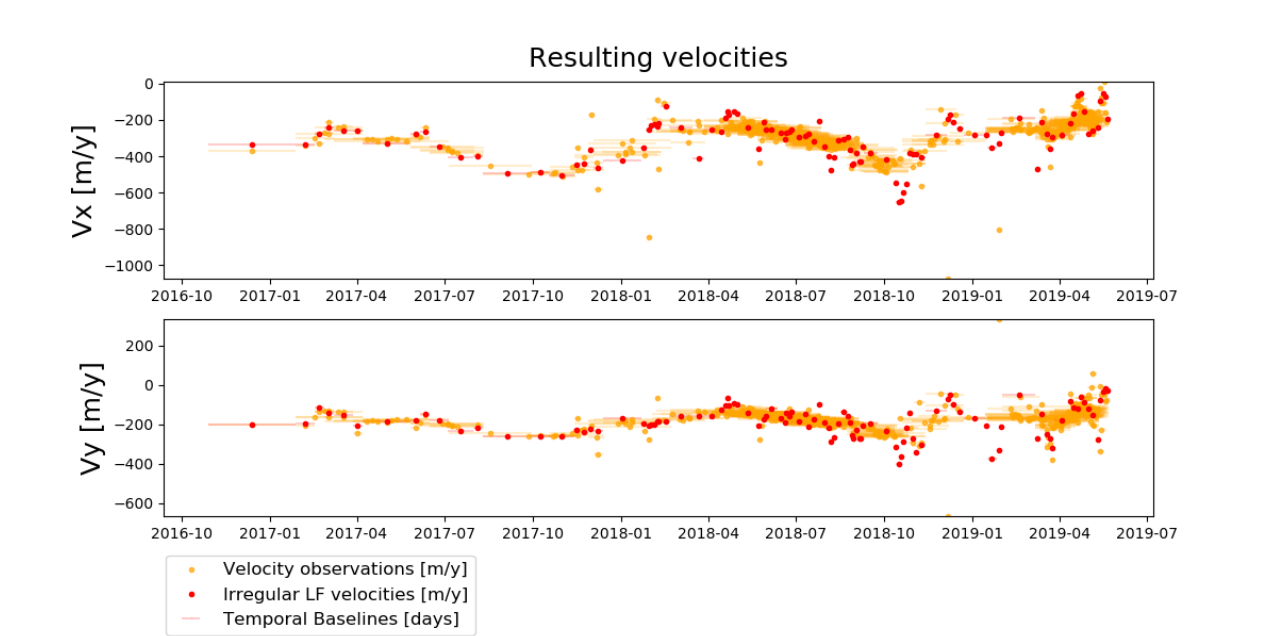
Figure 4. Velocity observations in gold overlayed with the Irregular Leap Frog time series obtained after temporal inversion in red for the point of coordinates (-43.532,170.134) labeled as the blue point in Figure 1.